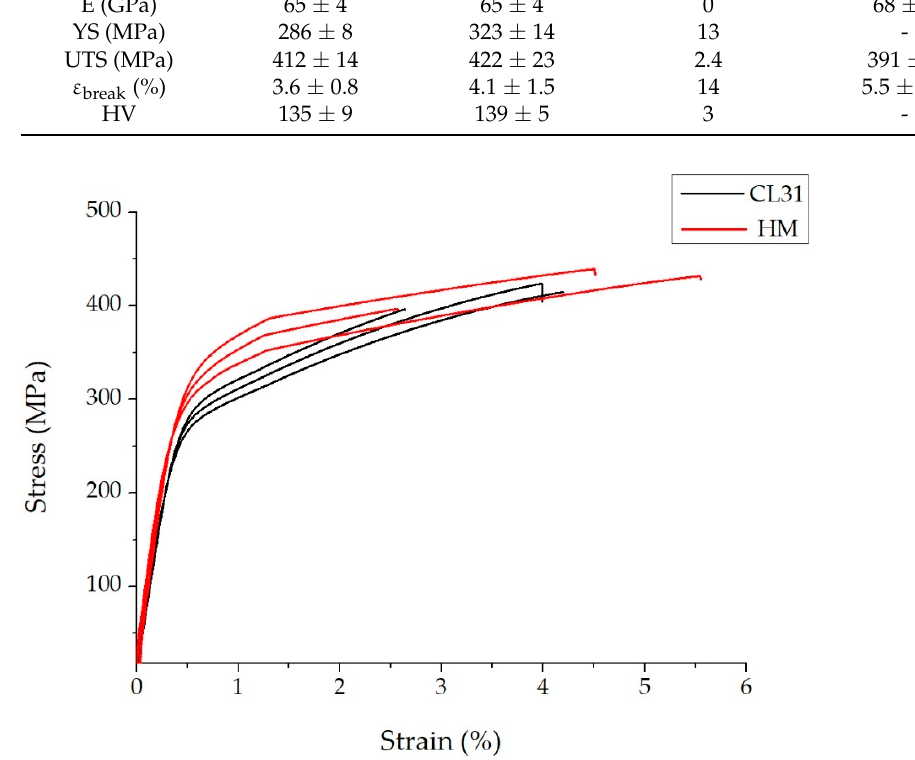
Table 6. Mechanical properties of the CL31 and HM samples, compared with the literature. Powder